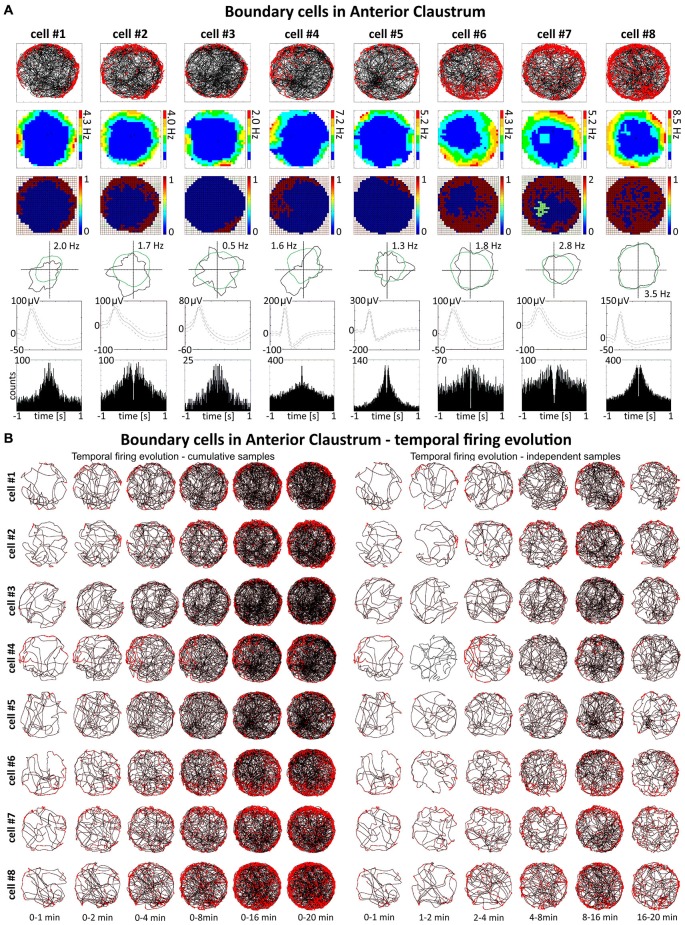
Boundary/border cells in rat anterior claustrum. (A) Cells that react with increased firing activity in response to the physical geometric borders of the environment. For each cell in columns are shown: path of the animal recorded during a 20-min session with superimposed firing activity; firing intensity map with a maximum firing frequency; place map; polar plot; spike waveform and autocorrelation ± 1000 ms. The visual cue was located in the same place as in Figure 1 in baseline conditions. (B) Temporal evolution of firing of boundary cells shown in (A). On the left, six samples of cumulative time intervals, and on the right, six samples of independent time intervals are presented in rows for each cell recorded during a 20 min session. Boundary cells responded through the whole session from the beginning to the end (an exception is cell #4 which did not respond during second minute of recording).